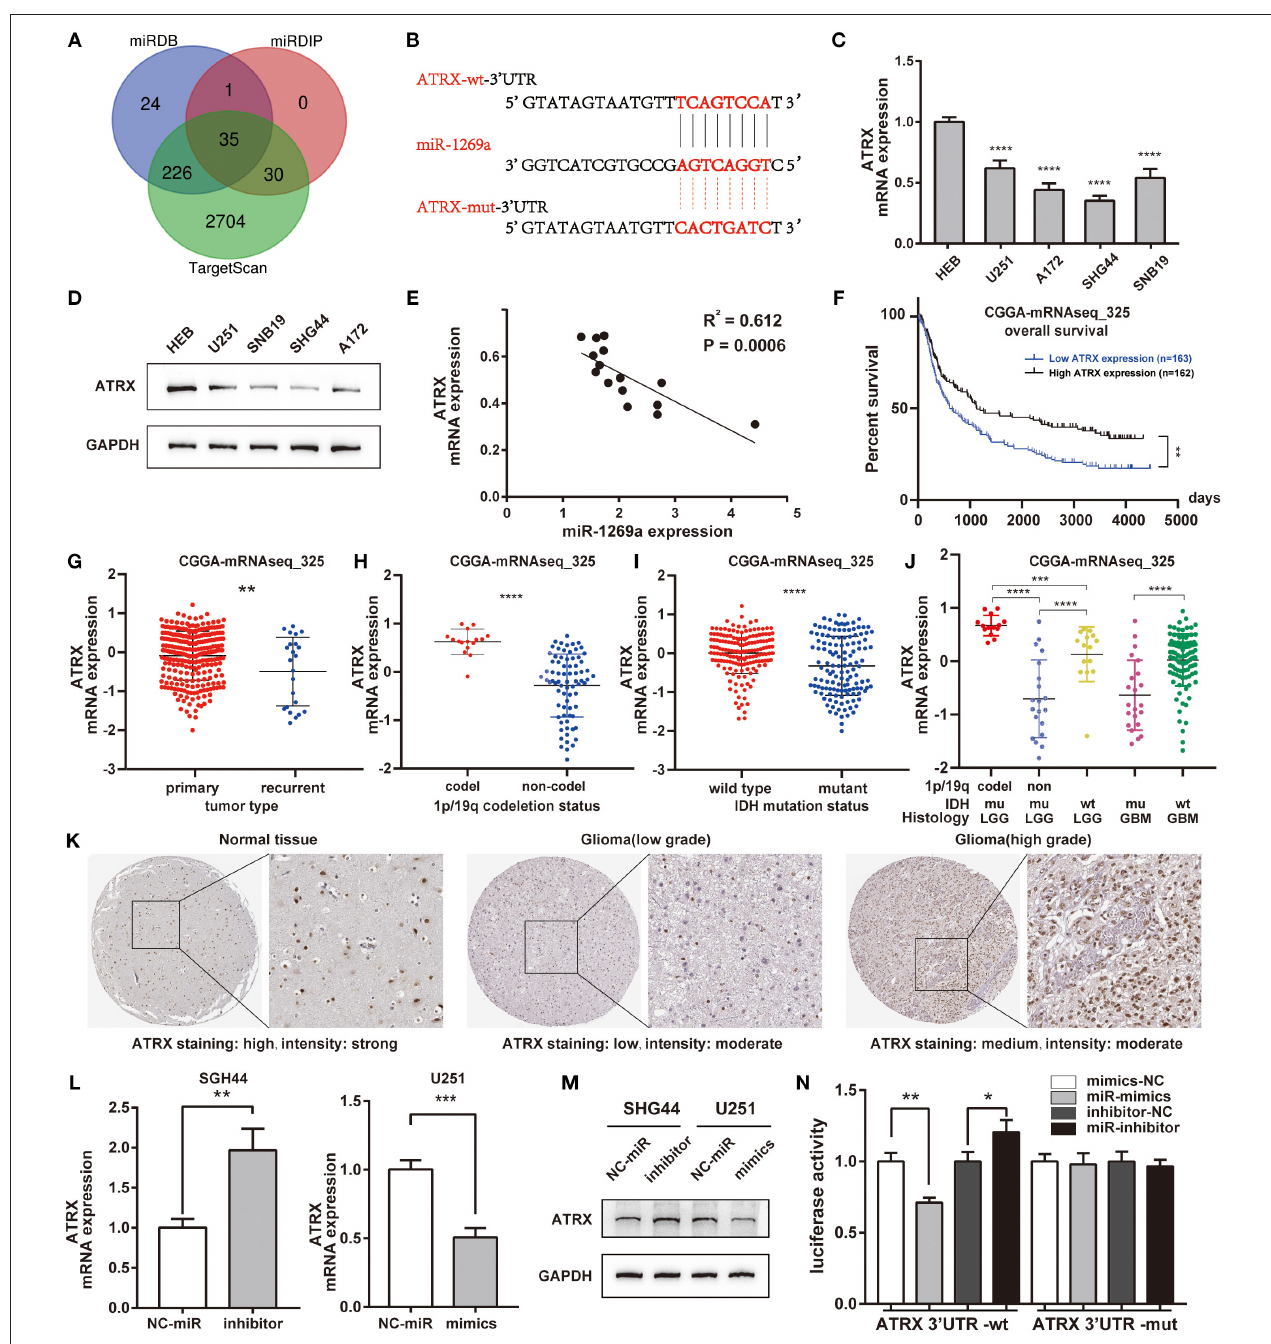
FIGURE 3 | ATRX is a direct target of miR-1269a and is correlated with poor characteristics and prognosis of glioma patients in datasets. (A) The direct target genes predicted by TargetScan, miRDIP, and miRDB are shown with a Venn diagram. (B) The binding site of miR-1269a and the 3 ′ UTR of ATRX as predicted by TargetScan. (C,D) The mRNA and protein expression levels of ATRX in U251, A172, SHG44, SNB19, and HEB were detected by qPCR and Western blot. (E) The expression levels of miR-1269a negatively correlated with those of ATRX mRNA. (F) The survival data in the CGGA database indicated that glioma patients with a low level of ATRX expression had a significantly worse overall survival compared with those with high level of ATRX expression. (G–J) Low ATRX expression positively correlated with tumor type (recurrent), IDH status (mutant), and 1p/19q non-codeletion. (K) Immunohistochemistry results obtained from the HPA database showed that ATRX was at low staining in glioma tissues but was heavily stained in normal brain tissues and was mainly localized in the nucleus of the cells. (L,M) The mRNA and protein expression levels of ATRX in a U251 cell with mimics and in an SHG44 cell with miR-1269a inhibitor were detected via qPCR and Western blot. (N) The targeting relationship was observed between miR-1269a and ATRX by the dual-luciferase reporter assay. * P < 0.05, ** P < 0.01, *** P < 0.001, and **** P < 0.0001.